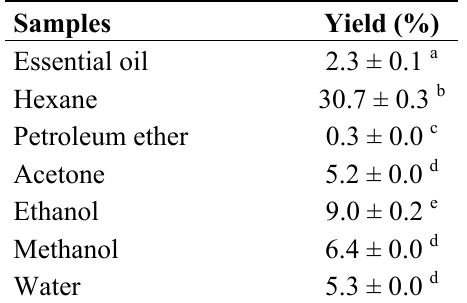
Table 2. Extraction yields (%) of essential oil and various extracts of E. gillii.